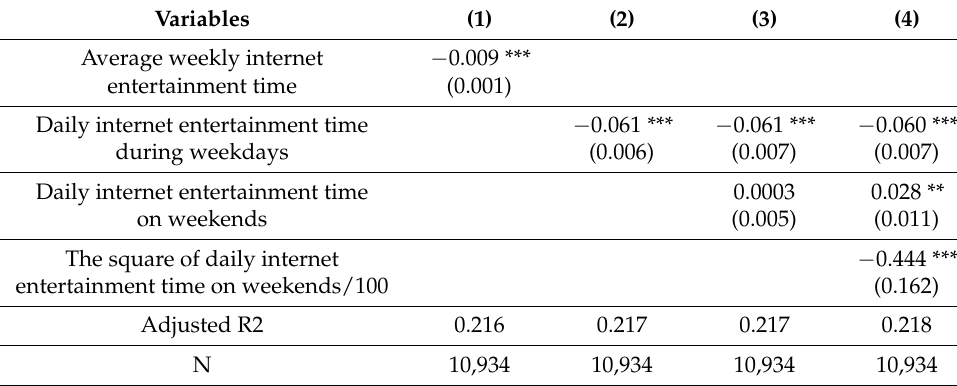
Figure 1. Children’s weekly extra-curricular time allocation. Table 8. Influence of internet entertainment time on cognitive